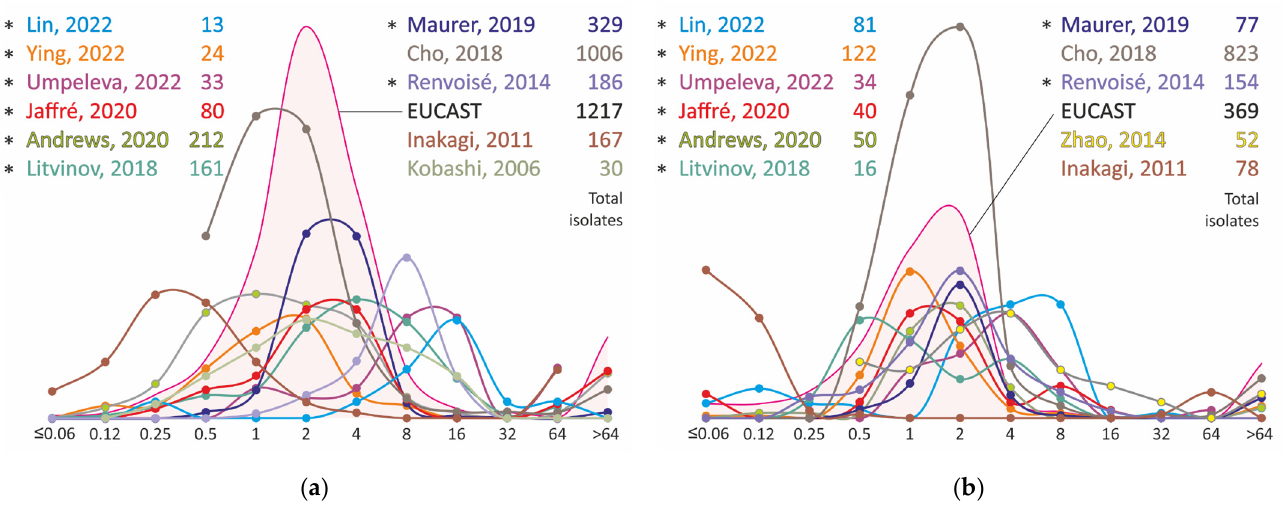
Figure 1. Clarithromycin MIC distribution for clinical isolates of M. avium ( a ) and M. intracellulare ( b ). * MIC obtained using Sensititre SLOMYCO plates.